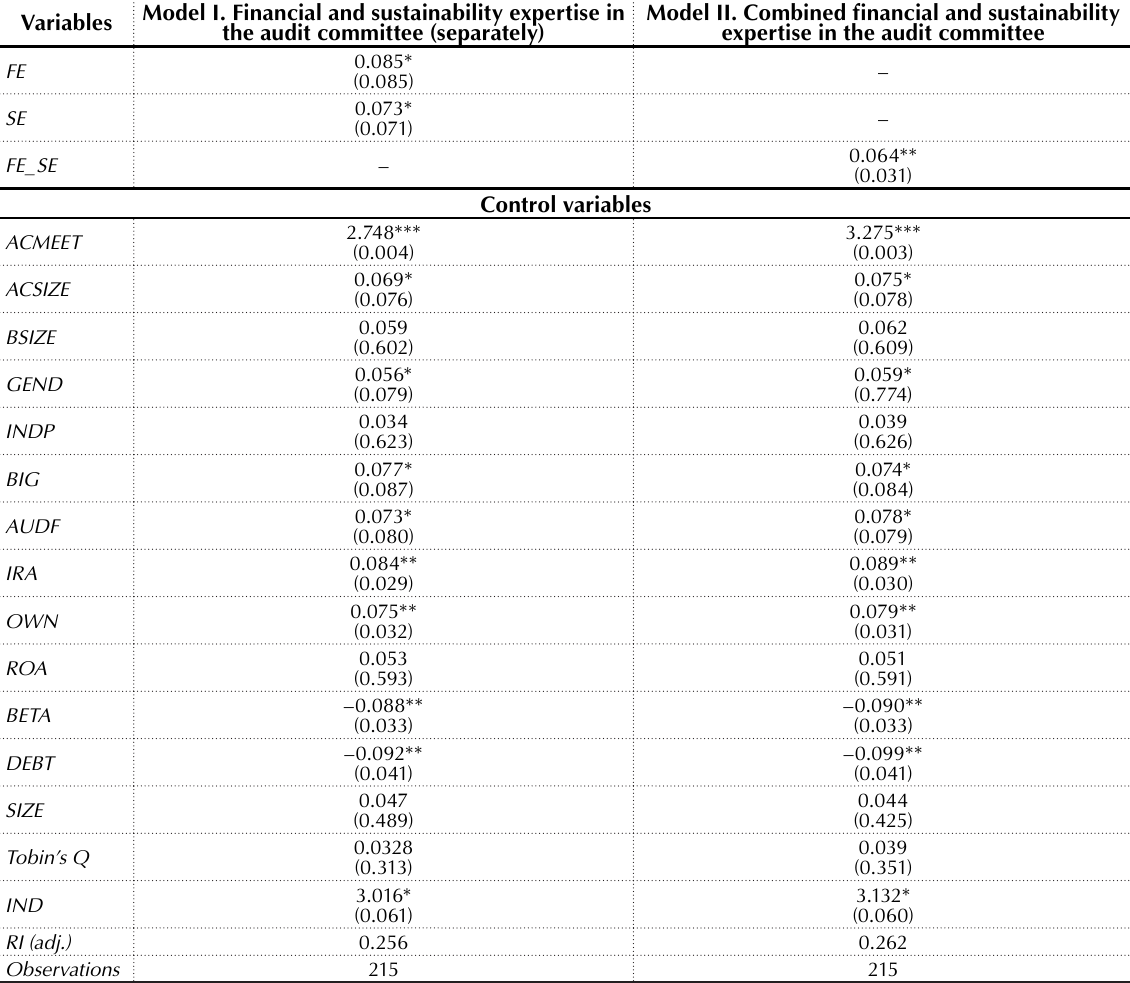
Table 8. Regression analysis (Flesch Reading Ease